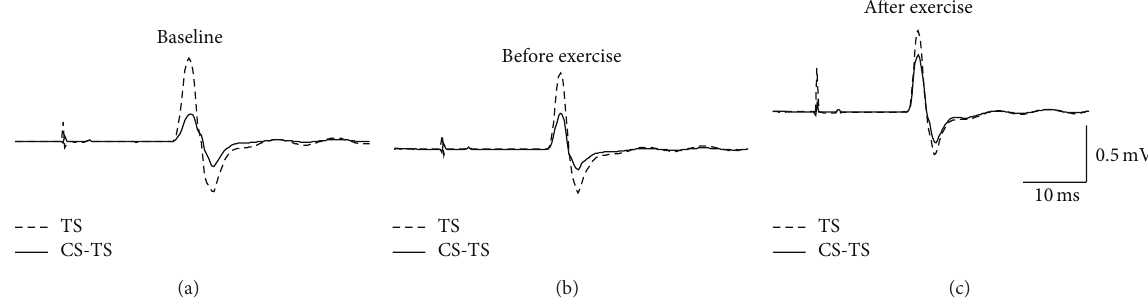
Figure 2: CBI in a single participant at (a) baseline, (b) before exercise, and (c) after exercise. MEP waveforms are averaged from 10 MEPs. Dashed waveforms show MEPs when the TS is delivered alone. Solid line waveforms show MEP waveforms when the TS was preceded by a CS delivered over the cerebellum. For this individual, the CS was delivered at RMT and preceded the TS by 7ms. TS: test stimulus; CS: conditioning stimulus.